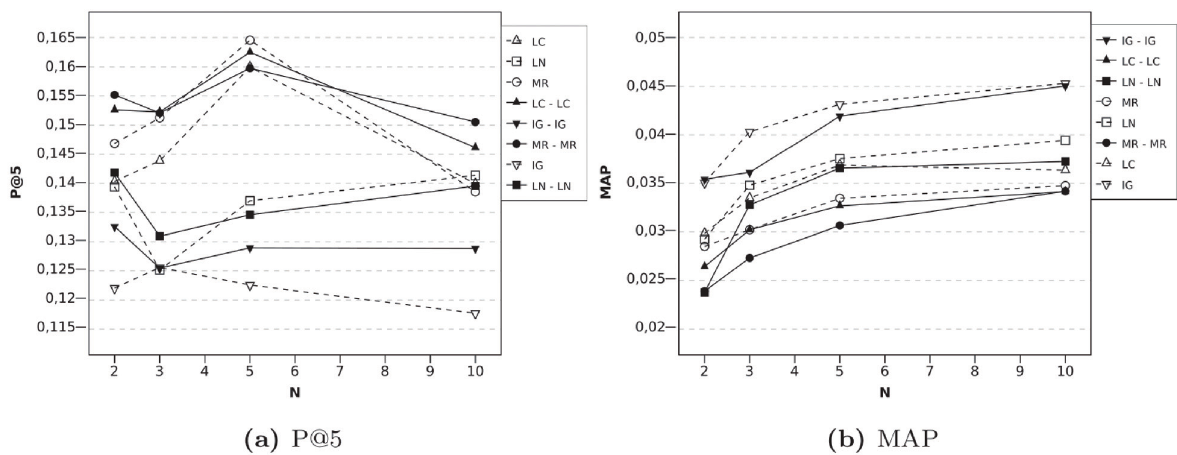
Fig 6. Evolution according to N, High Order Profile Expansion using the same algorithm twice and l = 2. Fig (a) reports P@5 results and (b) shows MAP.